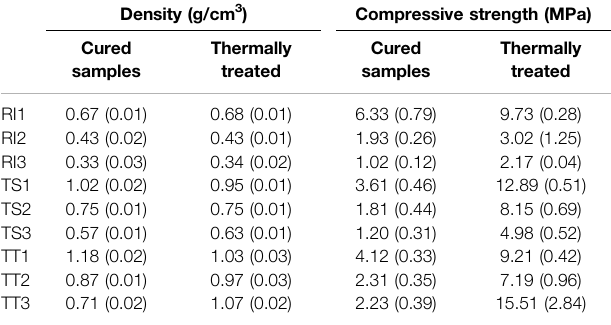
TABLE 3 | Density and compressive strength of the alkali-activated foams investigated when cured at 70 ° C and thermally treated at 1,000 ° C (the measured standard deviations are shown in